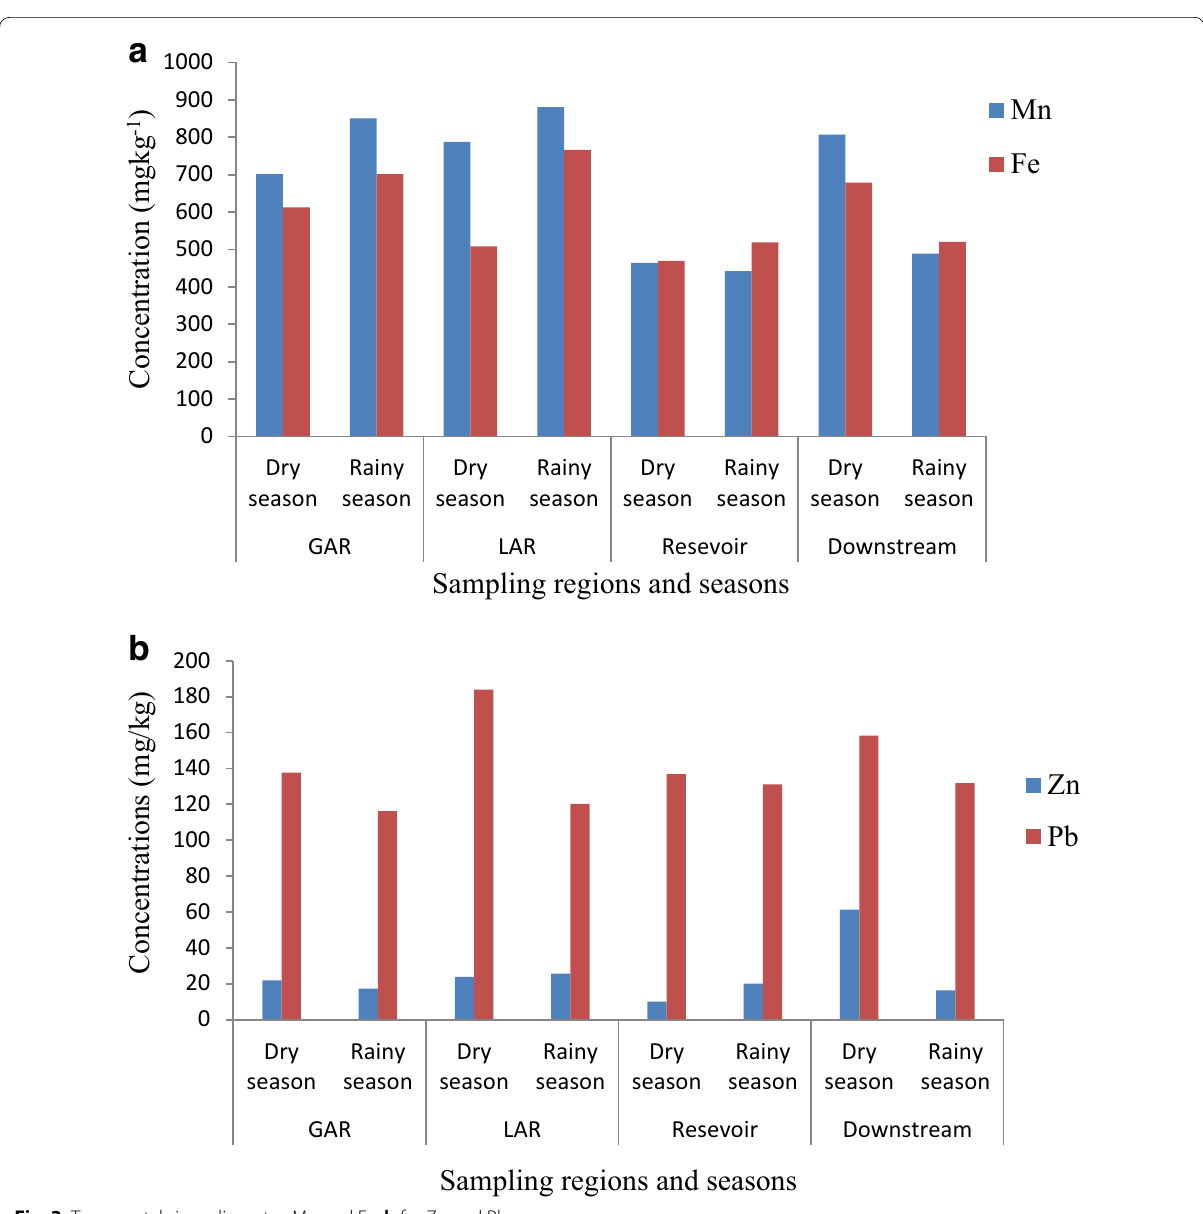
Fig. 3 Trace metals in sediment. a Mn and Fe; b for Zn and